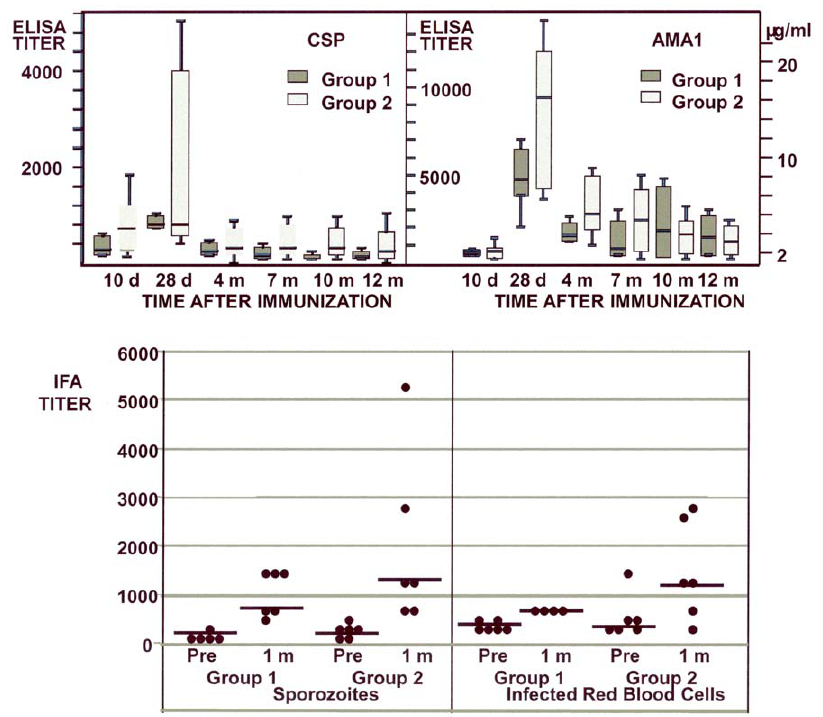
Figure 11. Group 1 and Group 2 anti-CSP and AMA1 antibody responses by ELISA and IFA. A and B : Box plots of the means and 25% and 75% percentiles of each group at 10 d and 1, 4, 7, 10 and 11–12 m after immunization. The first and third quartiles are the top and base of each box, and the upper and lower bars represent the high and low values respectively. C : IFA titers of each group pre-immunization and at 1 month post- immunization against sporozoites (left panel) and infected red blood cells (right panel). Bars represent geomeans.